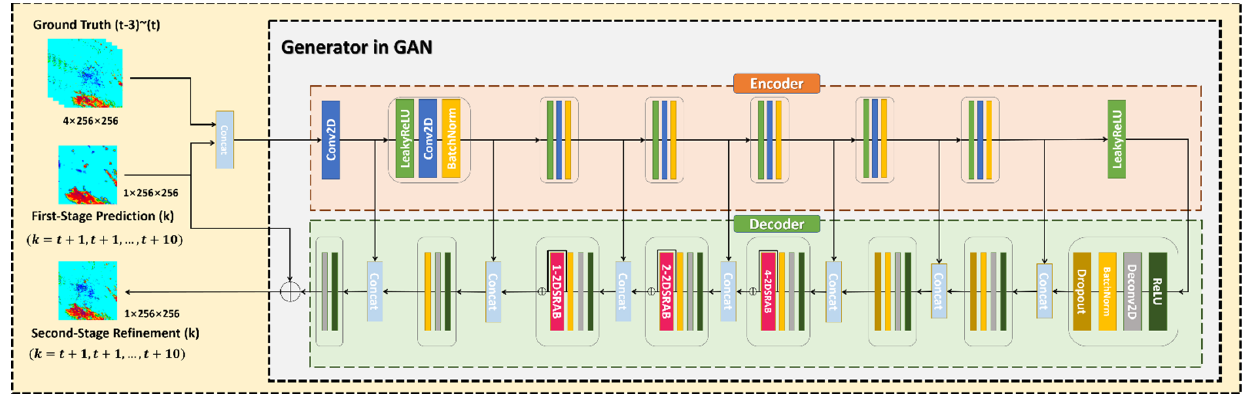
Figure 4. Structure of the generator in UA-GAN. It is a U-Net structure, also could be divided into two parts: encoder and decoder. Five echo frames including one predicted echo maps from first-stage prediction network, are input into the generator and one refined echo frame is output. Only one echo frame is optimized and refined at a time by the generator in UA-GAN.